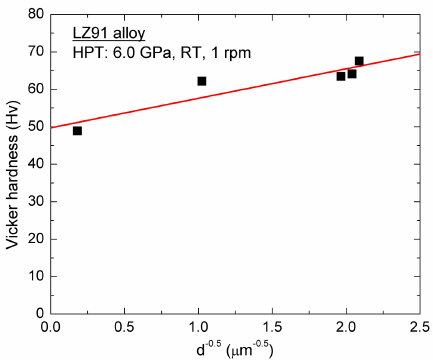
Figure 13. Relationship between Vickers microhardness and d − 1/2 for the LZ91 alloy before and after HPT through 1/4, 1 5 and 10 turns at the one-half radius